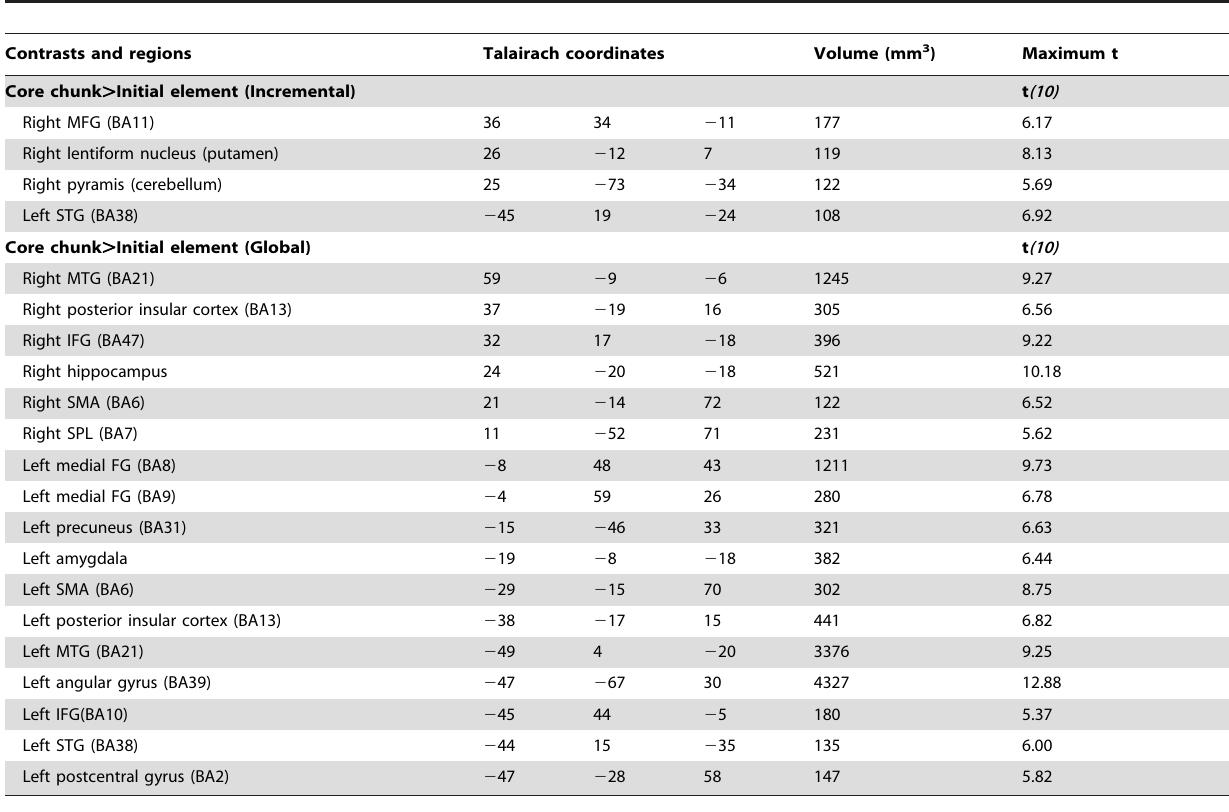
Table 5. Brain regions activated by contrast [ Core chunk . Initial element ] separately within each group.